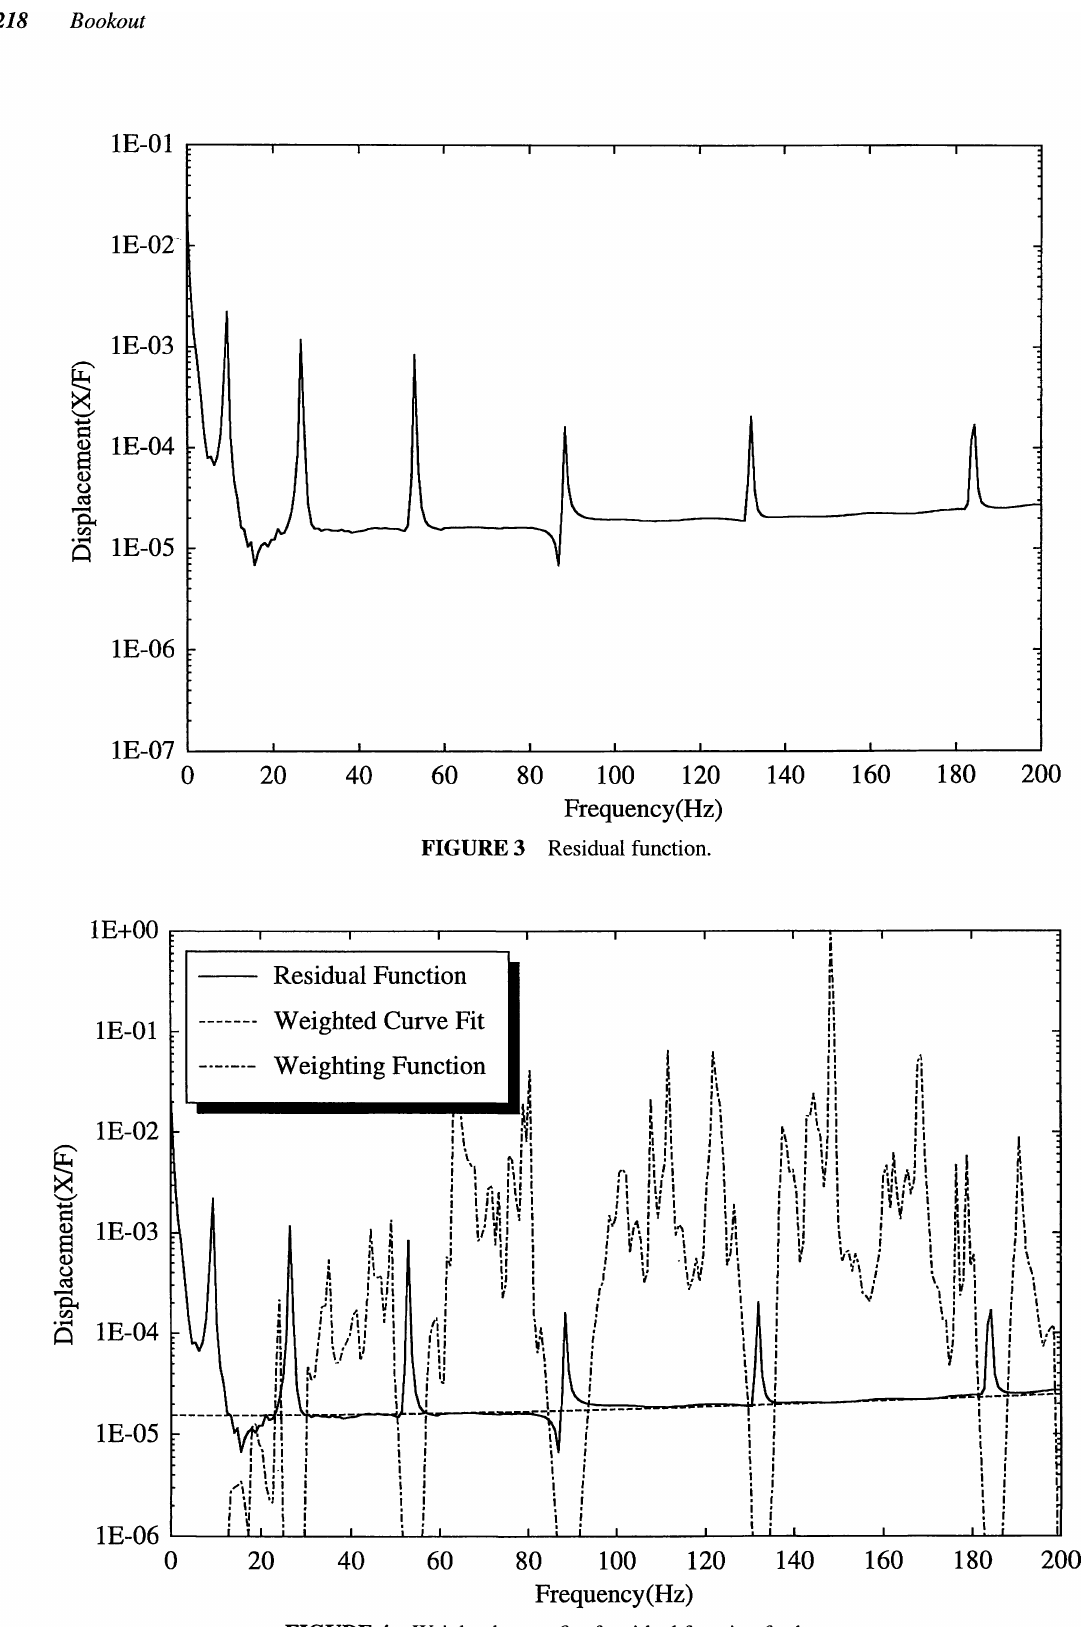
FIGURE 4 Weighted curve fit of residual function for